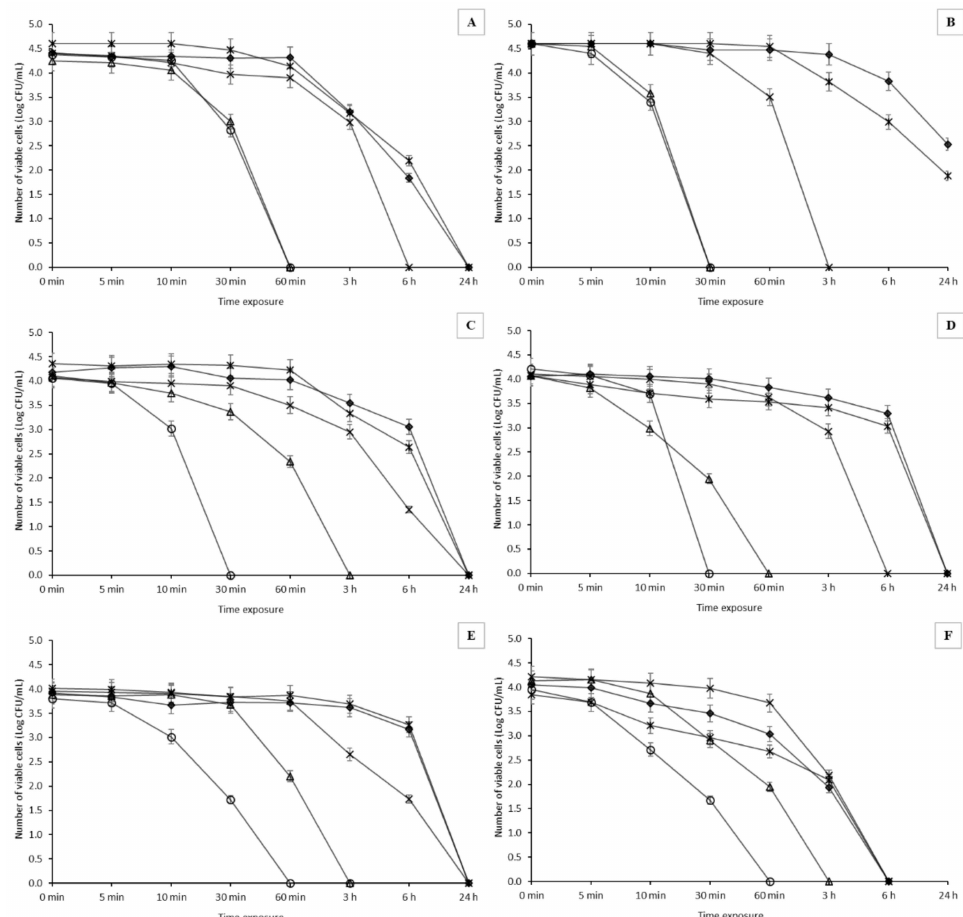
Figure 2. Survival of Arcobacter -like strains in the presence of BEOO at a sample concentration of 90%. Spanish extra-virgin olive oil (circle); Greek extra-virgin olive oil (triangle); blended sun- flower and extra-virgin olive oil (times); pure olive oil (diamond); olive pomace oil (asterisk). ( A )— Aliarcobacter butzleri CCUG 30484; ( B )— Aliarcobacter butzleri UPa 2013/30; ( C )— Aliarcobacter cryaerophilus CCM 7050; ( D )— Aliarcobacter cryaerophilus UPa 2013/13; ( E )— Aliarcobacter lanthieri LMG 28517; ( F )— Aliarcobacter thereius LMG 24488. The results are presented as a mean ± standard deviation. Statistical significance between the groups was assessed by ANOVA at 5%